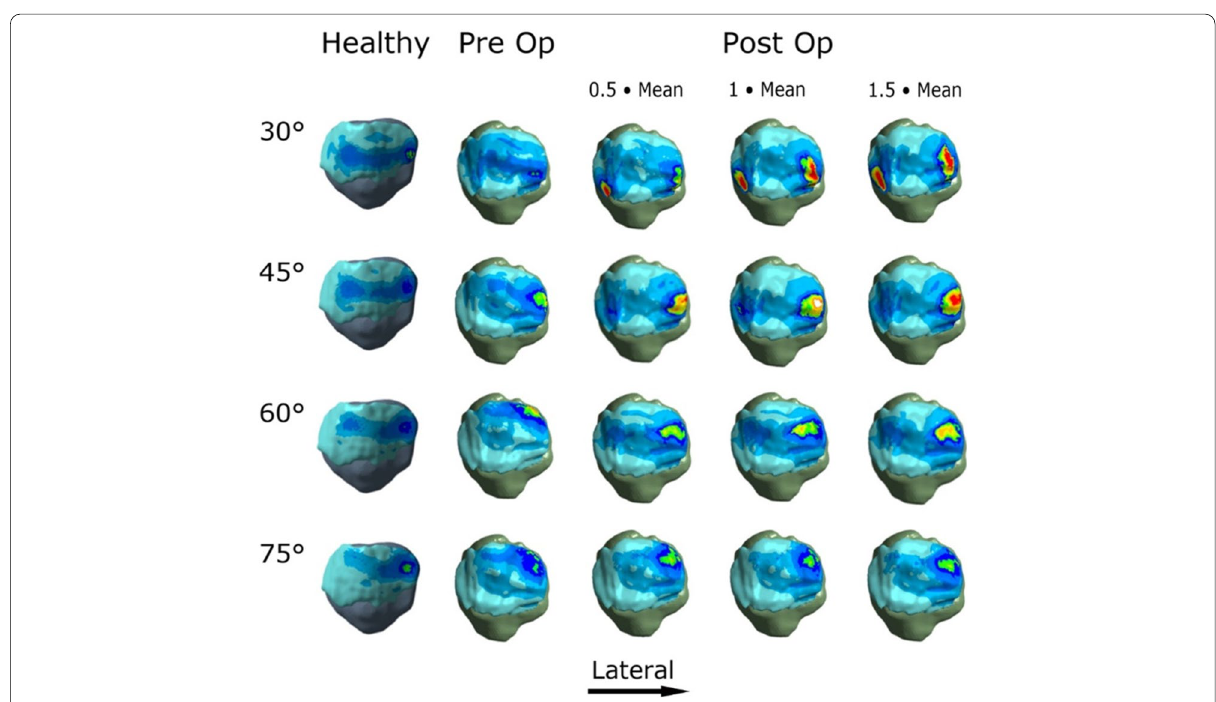
Fig. 4 Contact pressure patterns are superimposed over the patella for the healthy control knee and the dysplastic knee pre- and postoperatively at 30°, 45°, 60° and 75° of flexion. The postoperative models show the high pressure areas marked in red. The pressure scale is constant for all models. The color assignment is nonlinear to maximize color distribution. As the healthy model represents a left knee, the respective images have been flipped to facilitate comparison. Note the pressure peaks on the lateral facet, which is pronounced at 30 to 60° flexion as well as the additional pressure peak at 30 degree flexion on the medial facet. We believe that these are evoked by the articular incongruity at the site of the greatest bony